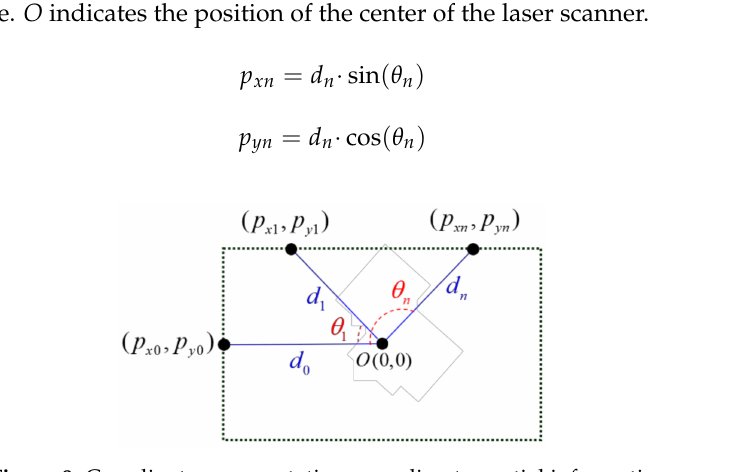
Figure 8. Coordinate representation according to spatial